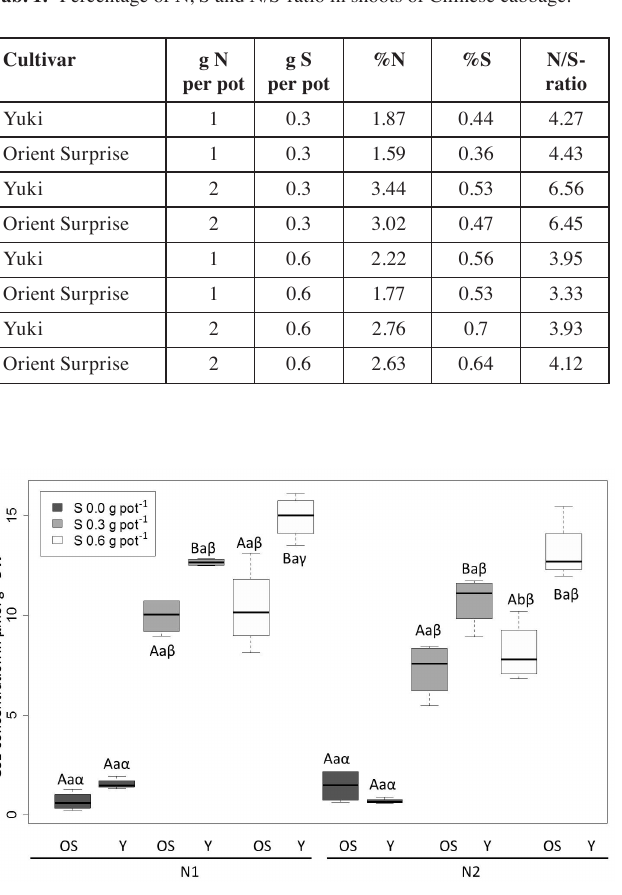
Fig. 4: Concentrations of indole GLSs, aromatic GLSs and aliphatic GLSs in the cvs. Orient Surprise (OS) and Yuki (Y) in dependency to the N (1.0 and 2.0 g pot -1 ) and S (0, 0.3 and 0.6 g pot -1 ) supply. N1, 1 g pot -1 ; N2, 2 g pot -1 . Uppercase letters represent significant dif- ferences between the cvs., lower case letters represent significant differences between the N treatments, and Greek letters significant differences between the S treatments (P < 0.05).